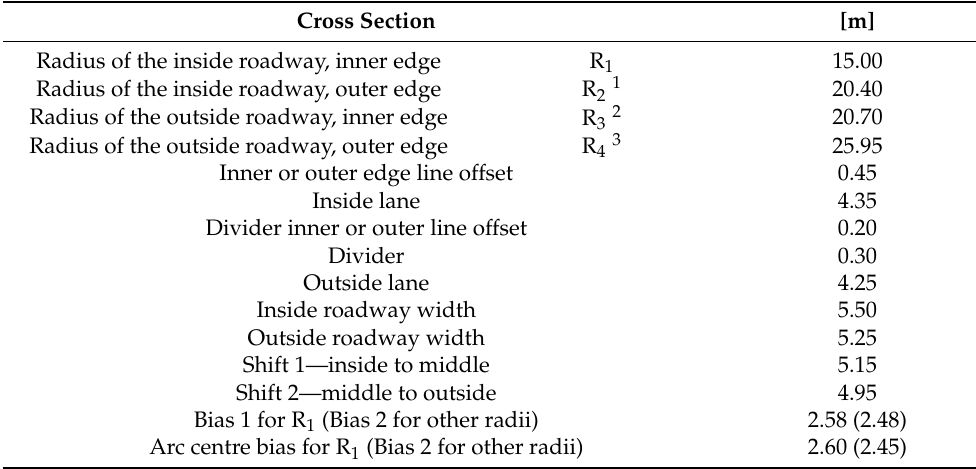
Table 7. Geometric conceptualization of the turbo roundabout.